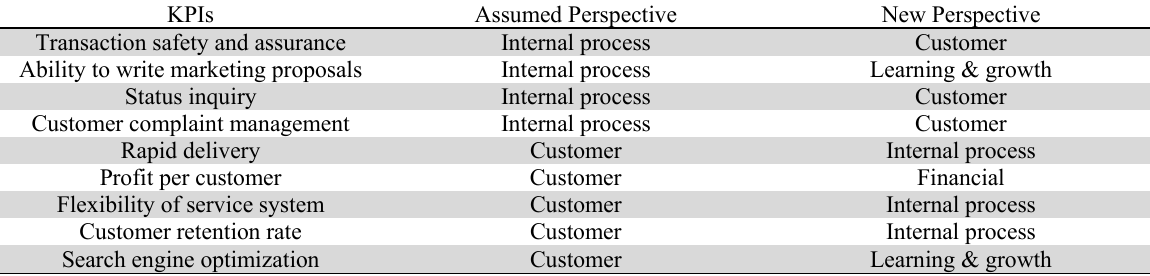
The results of changes in perspective of key performance indicators KPIs Assumed Perspective New Perspective Transaction safety and assurance Ability to write marketing